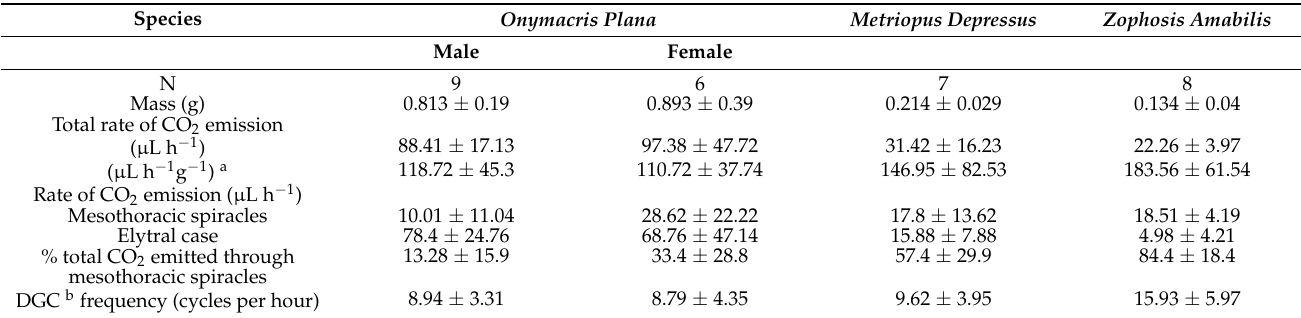
Table 1. Rate of CO 2 emission in three Namib Desert tenebrionid beetles, including the separation of emission from pair of mesothoracic spiracles and elytral case. (mean ±